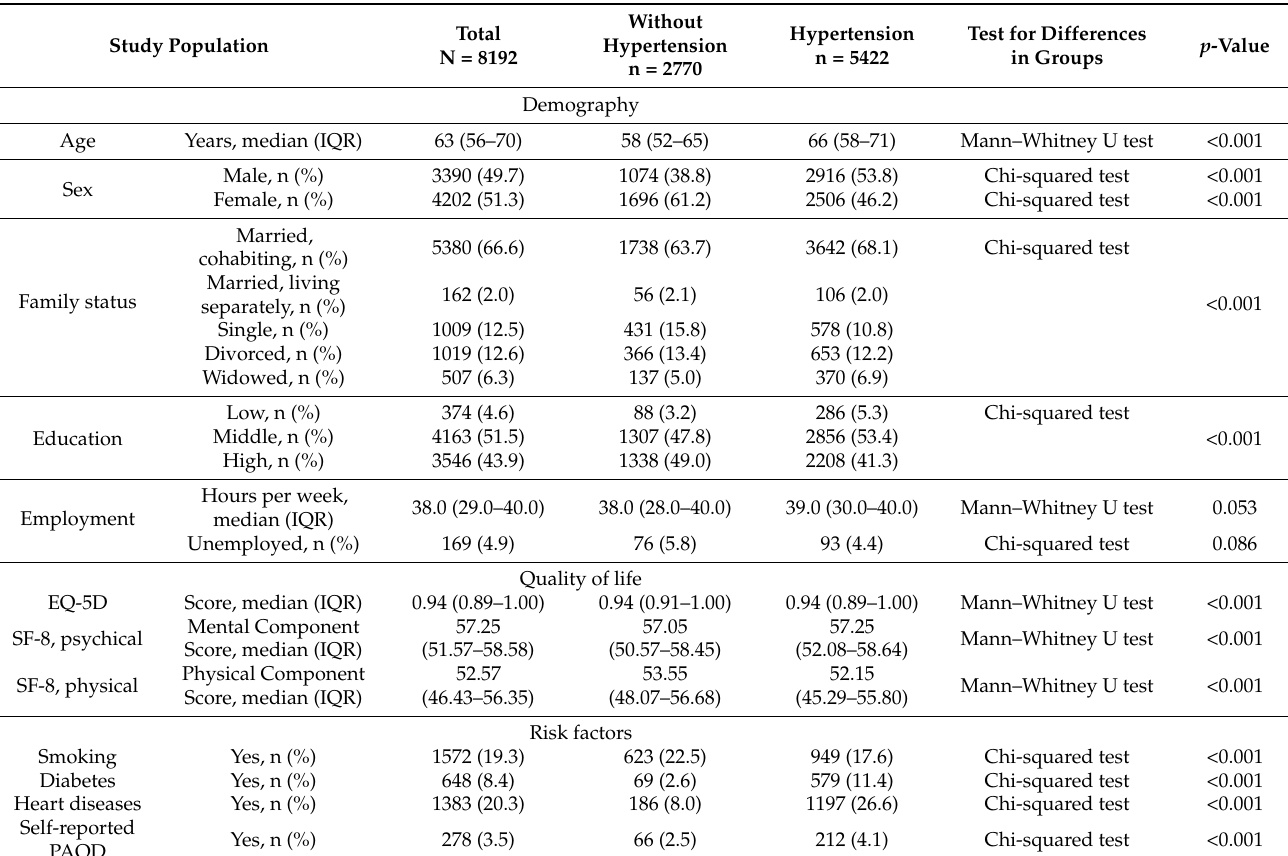
Table 2. Description of the study